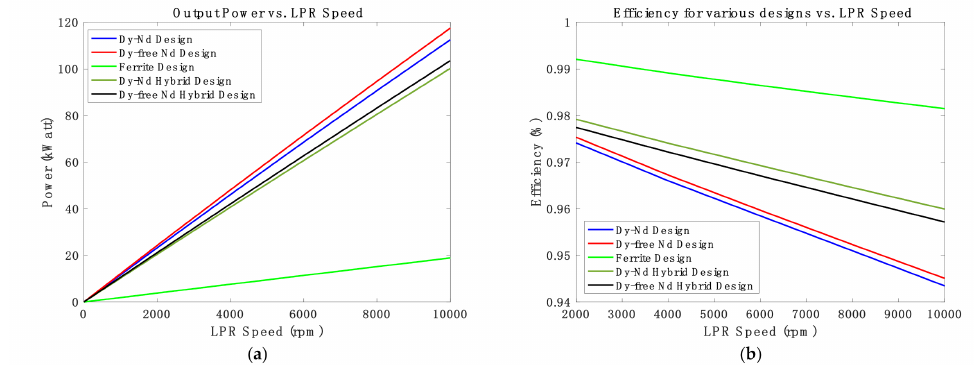
Figure 9. Electromagnetic performance for various FM-CMGs ( a ) mechanical power output, and ( b )